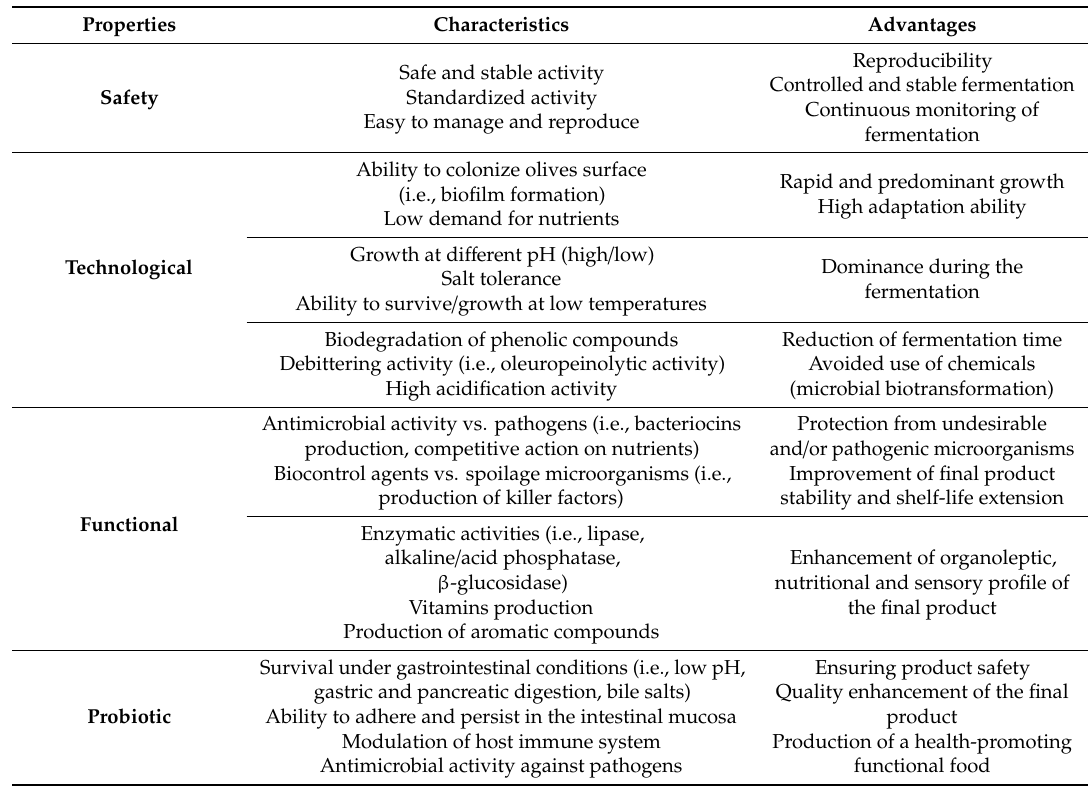
Table 2. Characteristics and advantages in the use of selected starter